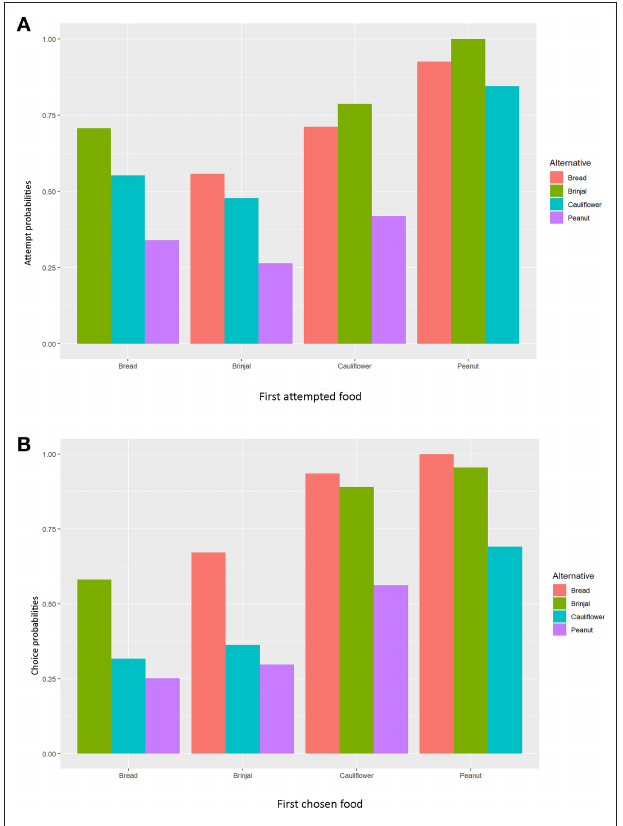
FIGURE 3 | Bar diagrams representing the normalized values of MLM estimates separately for (A) “attempt,” and (B) “choice” probabilities. The X-axis represents the (A) first approached and (B) first chosen foods.